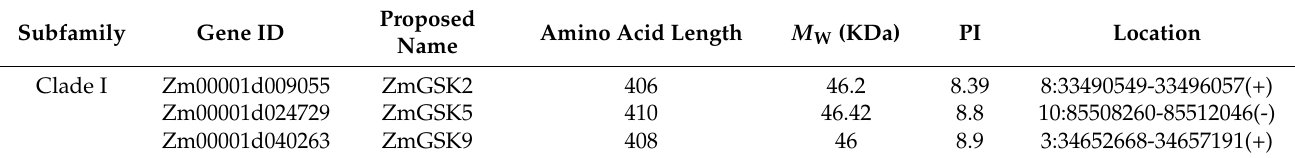
Table 1. Basic information of GSK